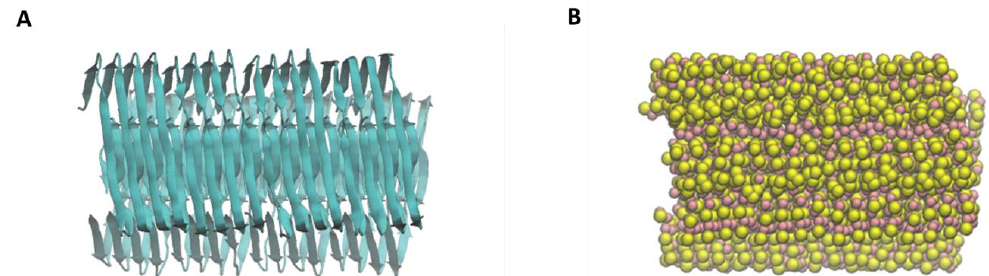
Figure 6. Molecular model of the amyloid fibril. ( A ) Visualization of atomistic structure of the fibril. ( B ) Visualization of coarse-grained structure of the fibril: pink beads correspond to the backbone of protein structure.